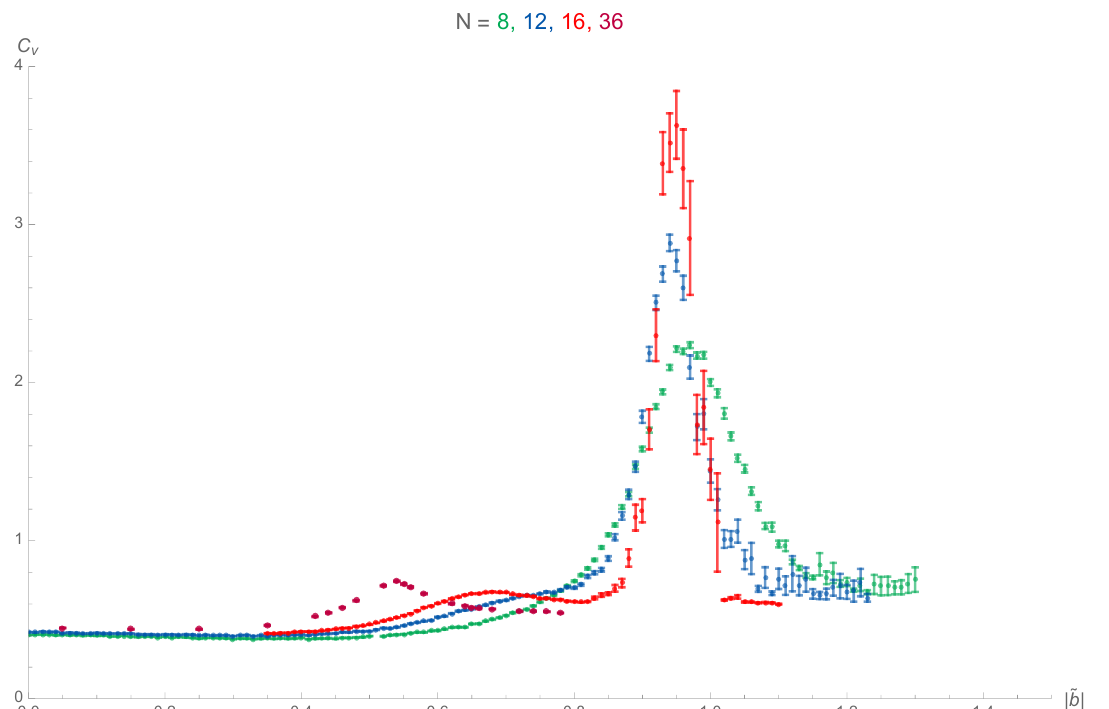
and we (cid:12)nd that the two 1